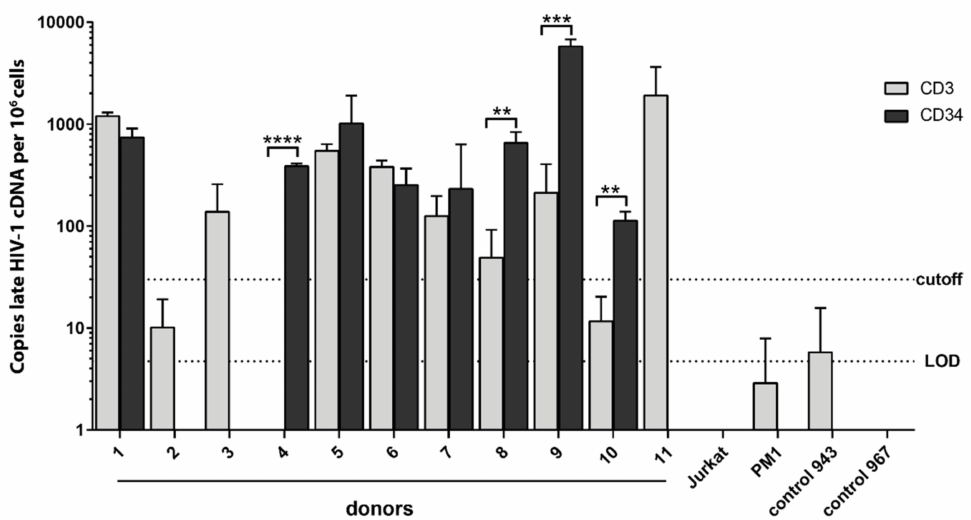
Figure 6. Detection of HIV-1 proviral DNA in CD34 + cells isolated from HIV-1 infected individuals. qPCR analysis using total (genomic and episomal) DNA of bone marrow-derived CD34 + and CD3 + cells isolated via sequential magnetic sorting from HIV-1 infected individuals. qPCR primers were specific for the HIV-1 R-U5 and gag region. Each sample was measured in technical triplicates. To determine the amount of copies per ng DNA, a PCR standard of the housekeeping gene RNAse-p was performed simultaneously on each sample. Numbers of late HIV-1 cDNA copies per ng gDNA (log 10 ) are shown as mean and SD. HIV-1-negative cell-lines (PM1, Jurkat) and HIV-negative cord blood cells (control 943 and 967) were used as negative controls. Cut off was set to 3 × SD of control 943. LOD: limit of detection. ** p < 0.01; *** p < 0.001; **** p < 0.0001. Clinical data of study participants